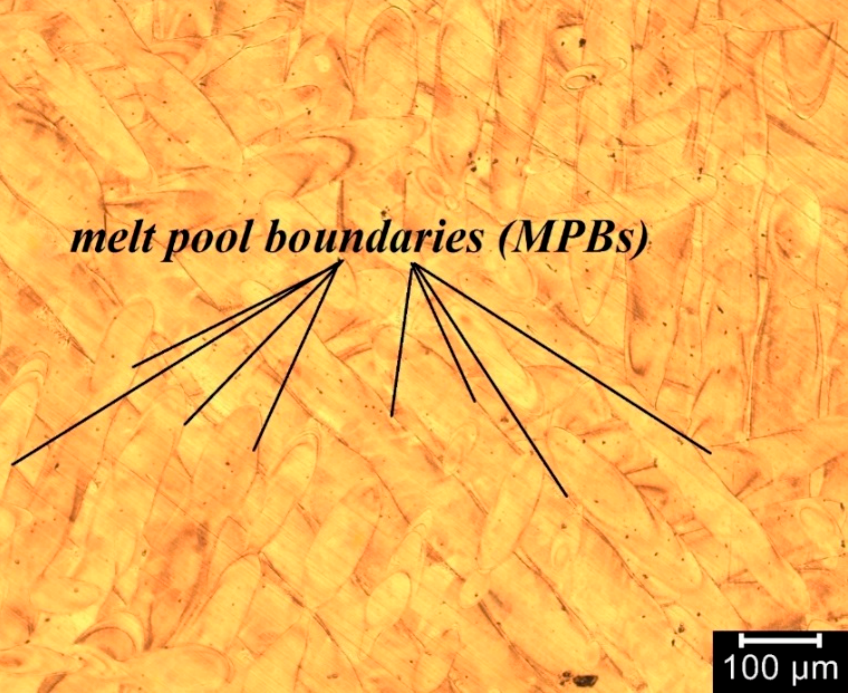
Figure 2. OM micrographs of as-built sample before hydrogen charging, produced by L-PBF. The image is perpendicular to the building direction.